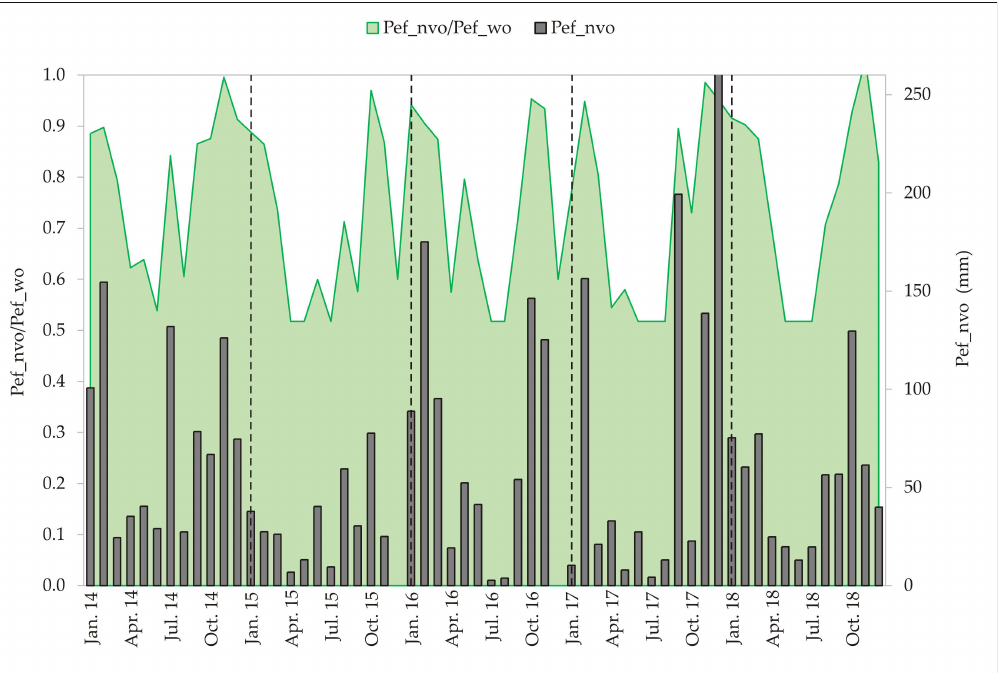
Figure 5. The ratio between monthly values of P ef calculated for the actual share of forest (67.6%) in the catchment of the Rižana River (Pef_nvo) and with the assumption that the natural vegetation overgrowth would not happen and the share of forest would remain the same as it was in 1957 (37.4%) (Pef_wo). To indicate the di ff erences between the dry and wet periods the monthly values of Pef_nvo are presented